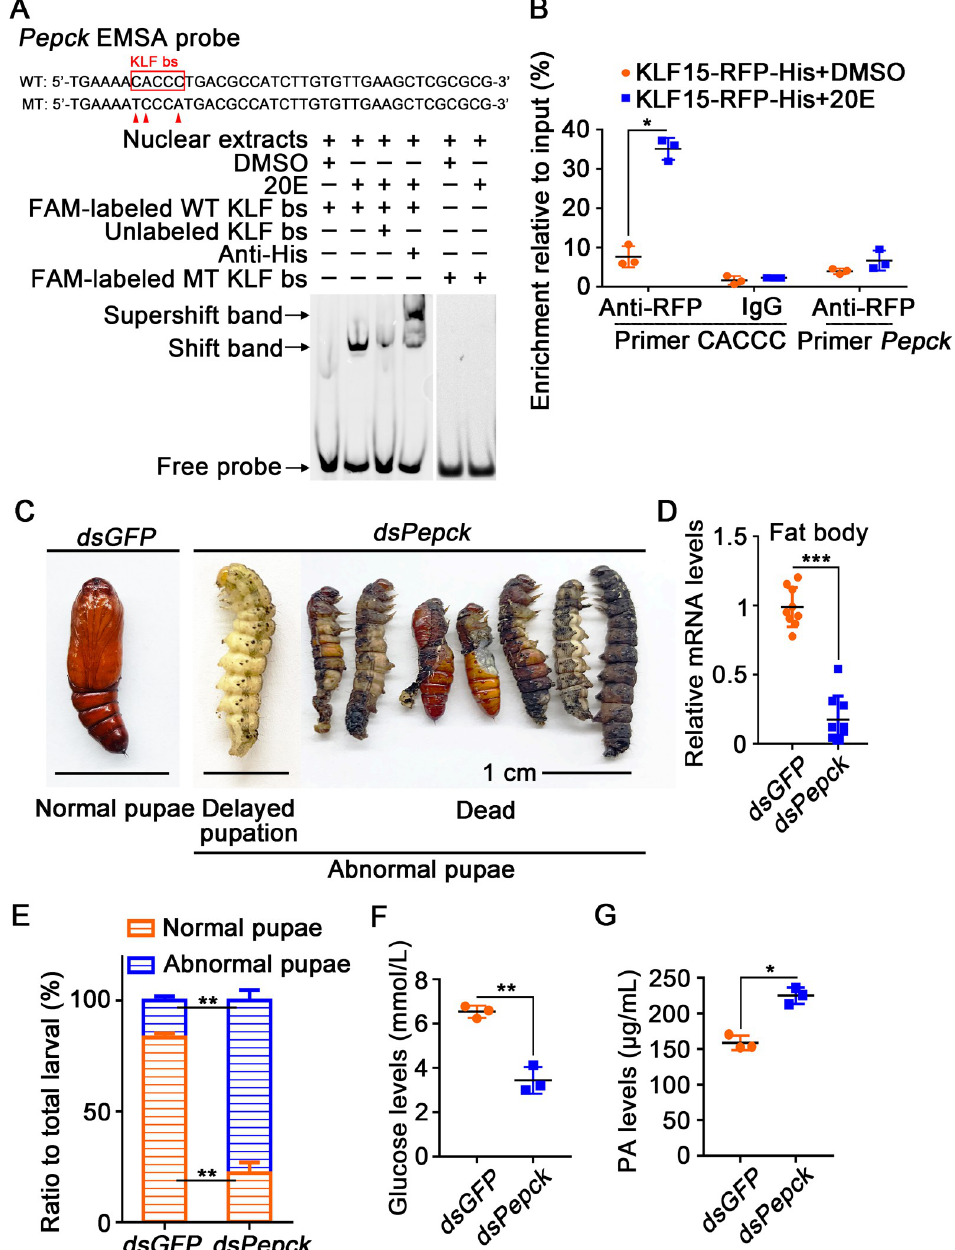
Fig 8. Knockdown of Pepck delayed pupation and decreased hemolymph glucose levels. A. KLF bs on the Pepck promoter bound to KLF15 detected by EMSA assay. B. ChIP assay showing 20E promoted Pepck expression via KLF15 binding to KLF bs. C. Phenotypes after injection of dsPepck and dsGFP from 6th-6 h to 72 h; the ruler represents 1 cm. D. qRT-PCR validation of the interference efficiency in the fat body after the third dsRNA injection. E. Ratio of phenotypes. F. Glucose levels in the hemolymph decreased after knockdown Pepck . G. PA levels in the hemolymph increased after knockdown Pepck . after the mid-pupa period, which appeared similar to the curve of 20E titer during metamor- phosis [22]. In the present study, we showed that 20E represses glycolysis and the synthesis of glycogen and trehalose by repressing the related genes expression to block the metabolic